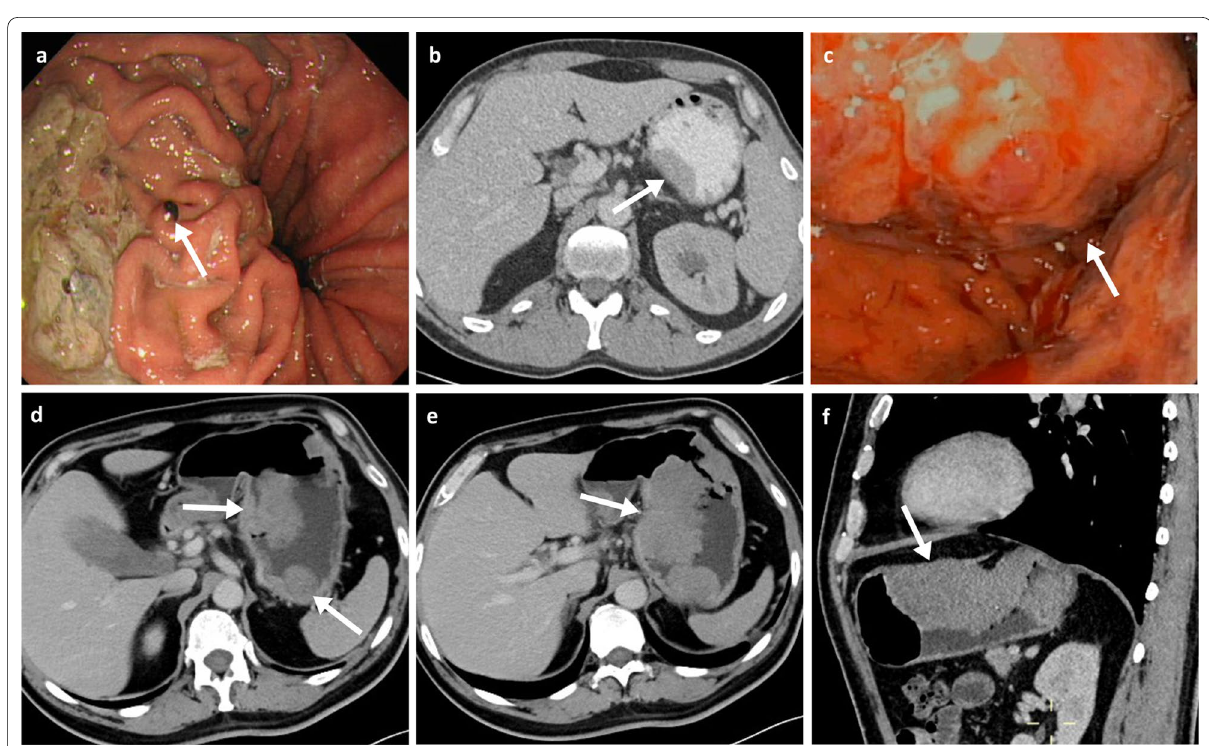
Fig. 3 Gastric melanoma metastases. a Endoscopy of a 69-year-old female patient with a melanotic nodule in the proximal gastric body (arrow). b Oral and intravenous portal phase contrast-enhanced CT axial of a 42-year-old male patient with a sessile soft-tissue melanoma metastasis associated with the lesser curvature (arrow). c – f Endoscopy and portal phase contrast-enhanced CT axial and sagittal of a 51-year-old male patient demonstrating a large melanoma metastasis within the body of the stomach with resulting luminal narrowing (arrows)